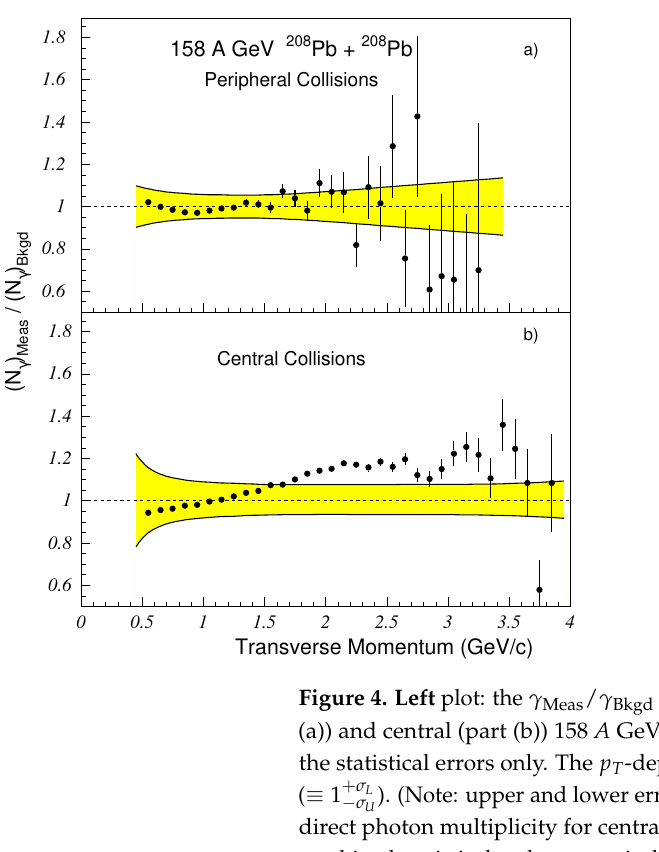
Right plot: the invariant